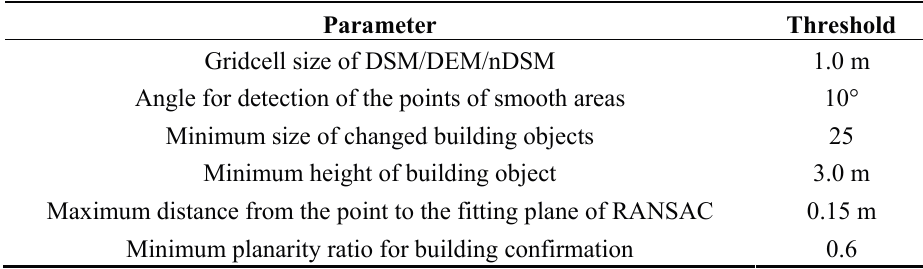
Table 1. Parameterset used in the experiment.